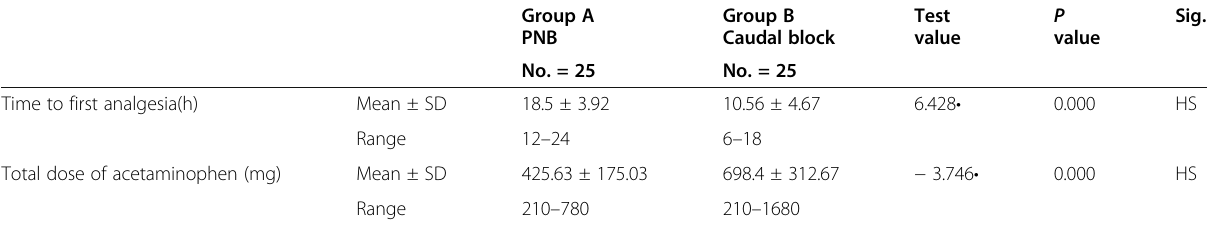
Table 5 Comparison between group A and group B regarding time to first analgesia given and total dose of analgesia acetaminophen in the first 24